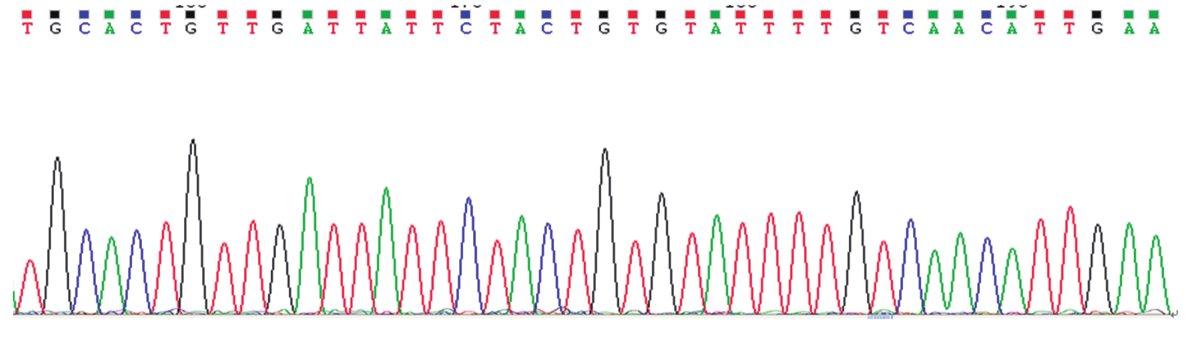
Figure 2 - The somatic DNA sequences in exon-6 of the IL6ST gene of our case represented the wide type sequence without any